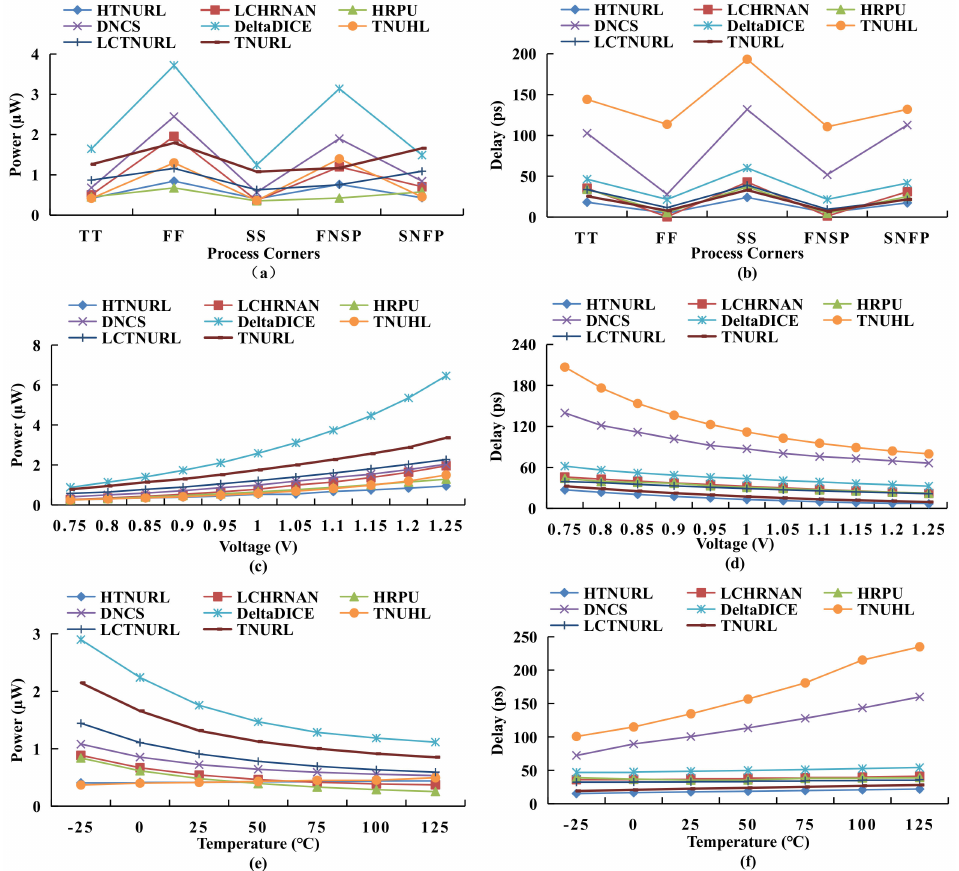
Figure 15. Assessment results of the PVT variations effect on the latches’ performances: ( a ) process corners vs. power; ( b ) process corners vs. delay; ( c ) supply voltage vs. power; ( d ) supply voltage vs. delay; ( e ) temperature vs. power; ( f ) temperature vs.